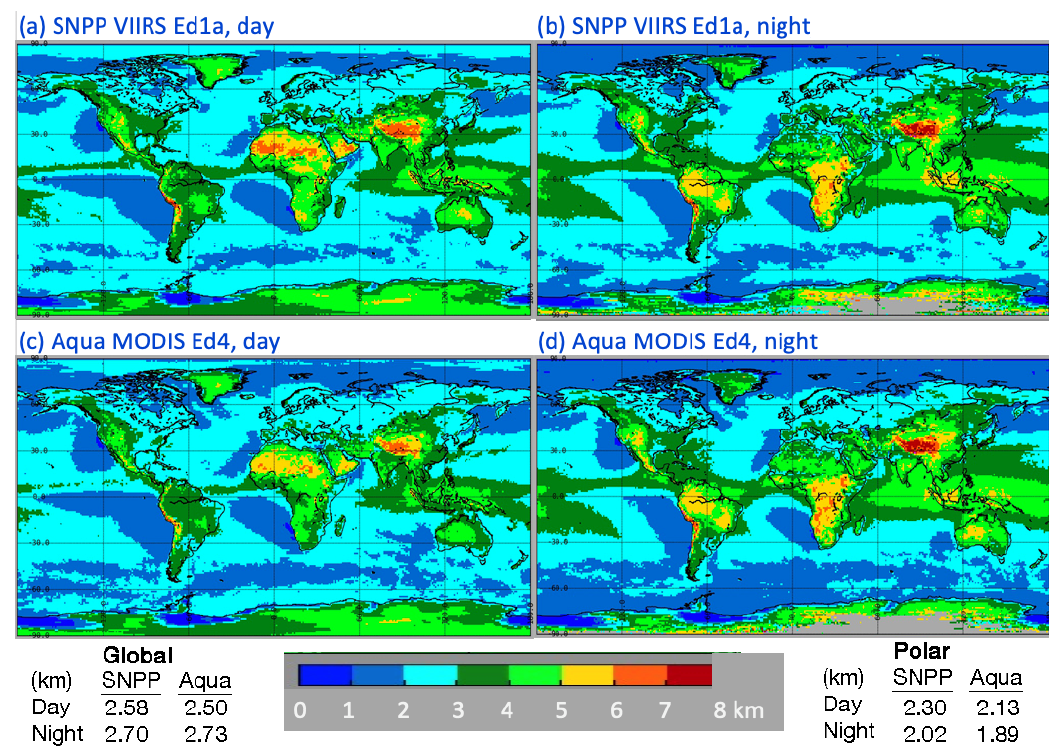
Figure 7. Mean 2013 daytime water cloud effective heights from SNPP Ed1a during ( a ) day and ( b ) night, and from CM4A for ( c ) day and ( d ) night. For ice clouds (Figure 8), daytime CEH (V) varies zonally for the most part (Figure 8a), much like CEH (M) (not shown). CEH (V) exceeds CEH (M) everywhere, except over tropical land (Figure 8c). At night (Figure 8b), CEH (V) is significantly less than CEH (M) over all tropical surfaces, but is greater than CEH (M) for most regions poleward of 30 ◦ latitude (Figure 8d). On average, for 2013, the CEH (V) is 0.51 km greater than CEH (M) over all areas during the day, while the two mean heights differ by only − 0.05 km at night.